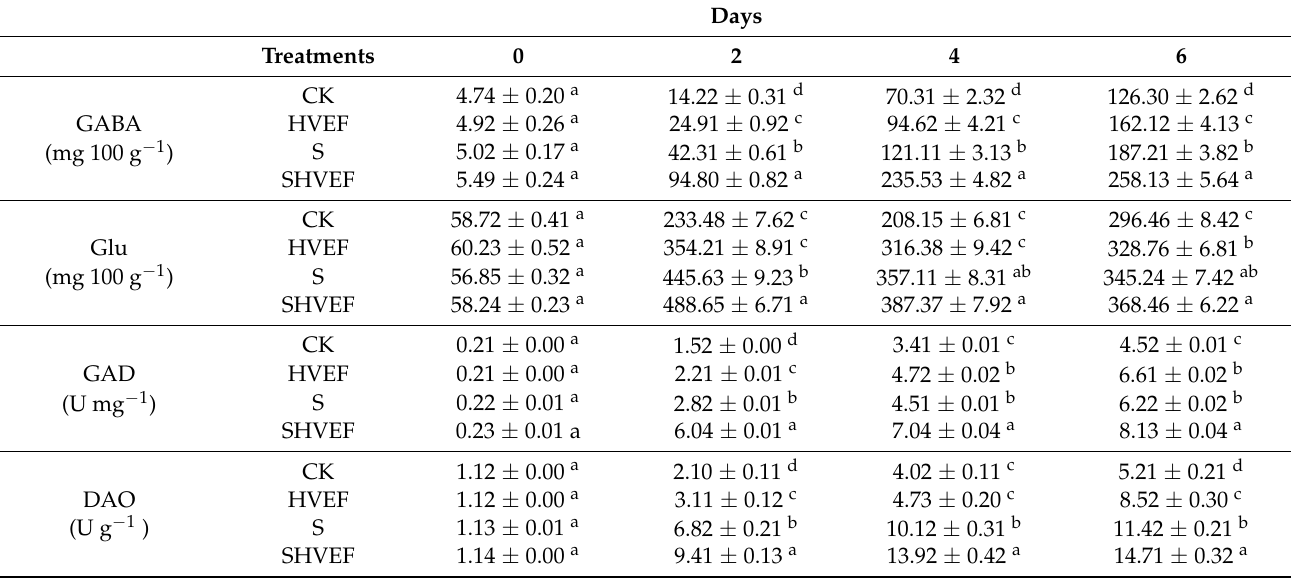
Table 2. Effects of soaking (S), high-voltage electric field (HVEF), and S+HVEF(SHVEF) treatments on the changes in γ -aminobutyric acid (GABA) and glutamic acid (Glu) contents, and glutamate decar- boxylase (GAD) and diamine oxidase (DAO) activities of adzuki bean sprouts during 6-day sprouting. Days Treatments